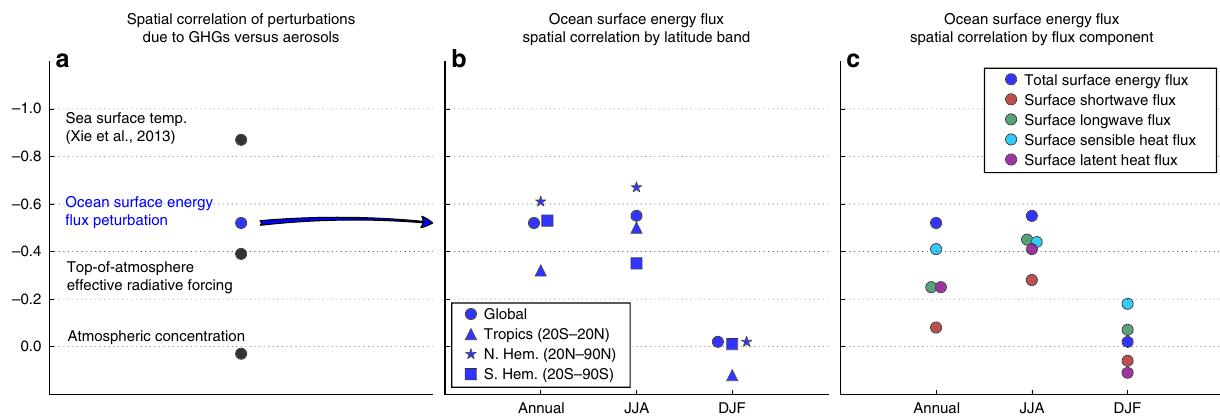
Fig. 1 Spatial correlations of perturbations due to greenhouse gases vs aerosols. a The spatial correlation of the ocean-masked surface energy fl ux perturbation due to greenhouse gases vs aerosols (blue dot) is substantially greater than that of the atmospheric concentrations of the two forcers or the top-of-atmosphere effective radiative forcing, and achieves approximately two-thirds of the spatial correlation in the eventual sea surface temperature response 3 . Decomposition of the ocean surface energy fl ux pattern correlation seasonally by latitude band ( b ) and by surface energy fl ux component ( c ) shows that the spatial correlation manifests most strongly in the surface heat fl uxes over the summertime Northern Hemisphere